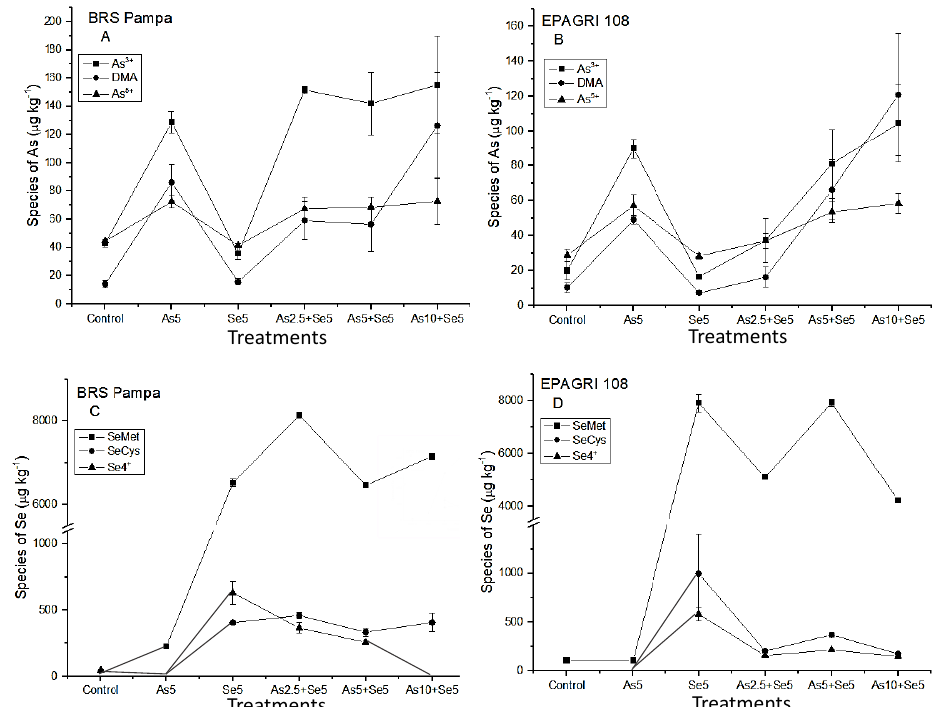
Figure 2. As and Se species in the grains of the cultivars tested. Chemical species and treatments that presented values below LOD: BRS Pampa C: SeMet/SeCys in Control; Se 4+ /SeCys in As5; Se 4+ in As10 + Se5; EPAGRI 108 D: SeCys/Se 4+ in Control and As5: ( A ) arsenic species in the grains of BRS Pampa; ( B ) arsenic species in the grains of EPAGRI 108; ( C ) Se species in the grains of BRS Pampa; ( D ) Se species in the grains of EPAGRI 108.